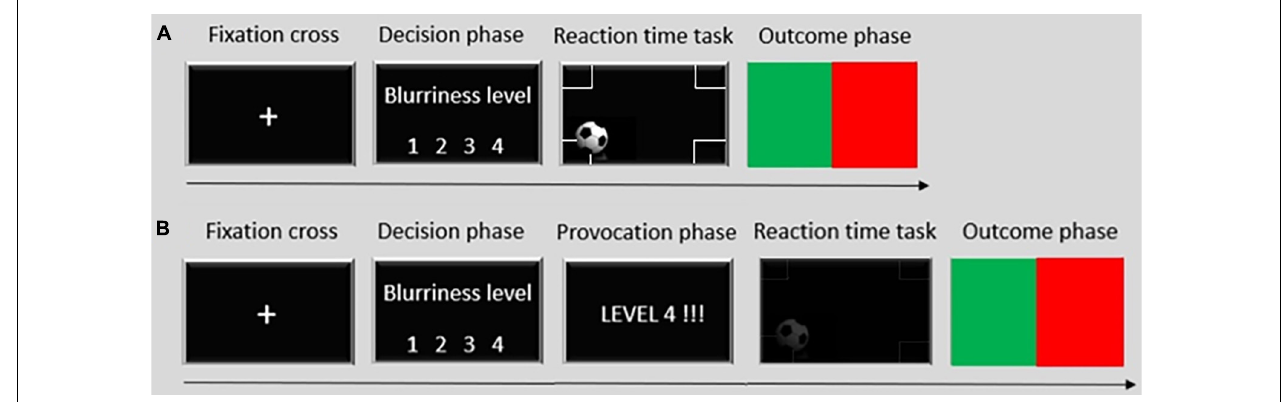
FIGURE 1 | Visual description of (A) one trial of the proactive Taylor Aggression Paradigm and (B) one trial of the reactive Taylor Aggression Paradigm. Fixation cross : participants look at a fixation cross. Decision phase : participants have 5 s to select the level of interference for the opponent on a level from 1 (no blurriness) to 4 (maximum blurriness). Provocation phase (only in the reactive version of the paradigm): participants see the blurriness level the opponent chose for them. Reaction time task : participants play the game, in which they have to press a button as fast as possible when a ball enters any of the target areas at the corners of the field. In the proactive version, they always play at level 1. In the reactive version, they play at the level chosen by the opponent. Outcome phase : participants see the outcome of the game represented by a green flash of light if they won and a red flesh of light if they lost. Participants played 40 trials for each task